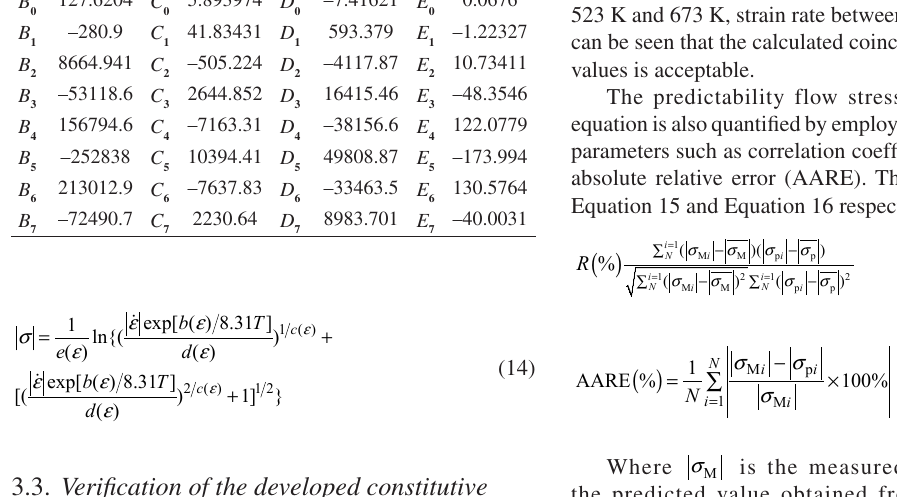
0.0676 0 –1.22327 1